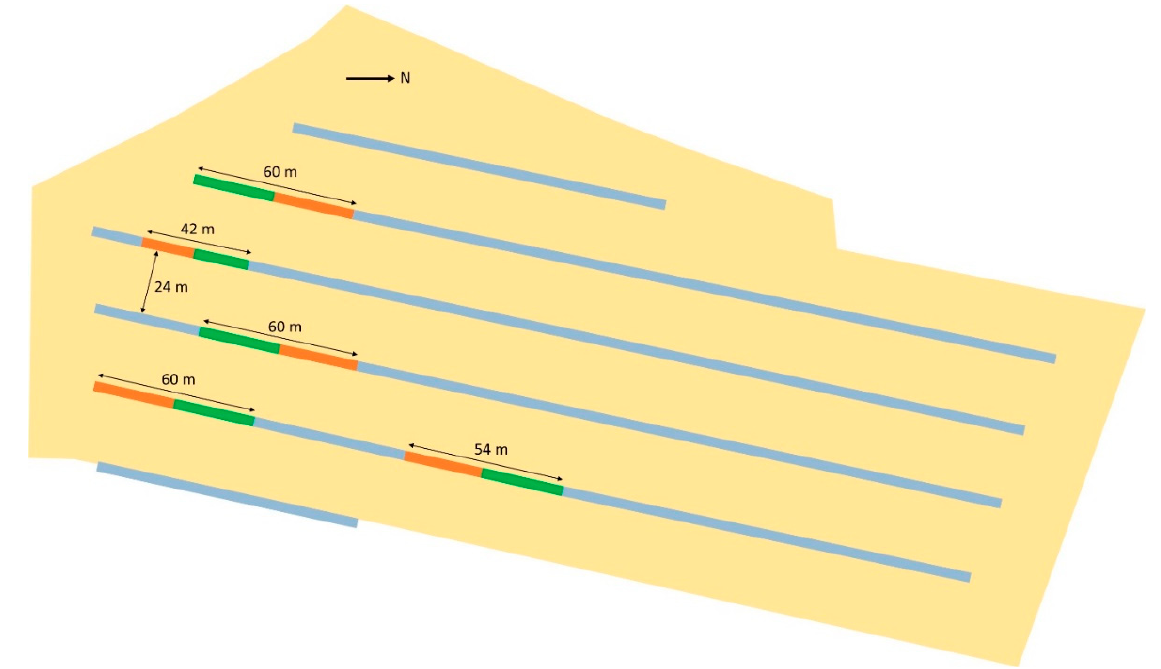
Figure 1. Schematic of the study field, where light orange = arable cropping, green = flowering understorey, orange = mown understorey, light blue = tree rows outside the experimental blocks, but subject to the same management as the flowering understoreys. All tree rows contained the same seed mix; treatments differed only in cutting frequency.